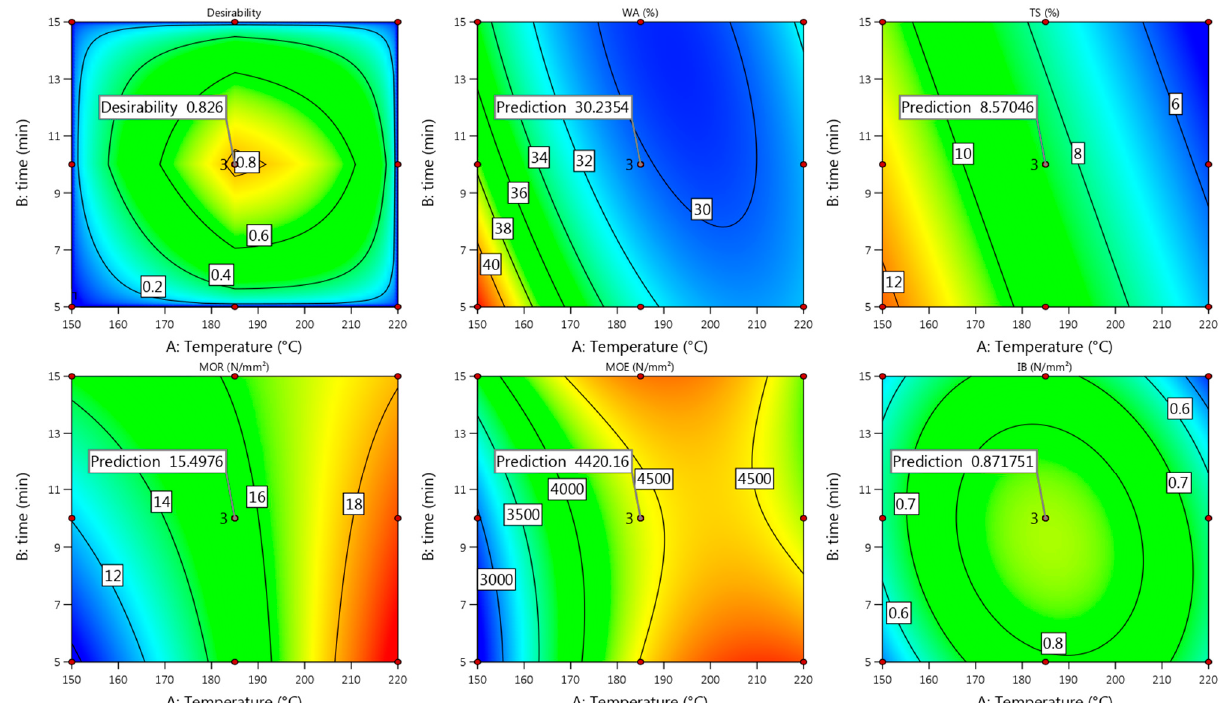
Figure 10. Contour plots with predicted values of Uso-1000 binder-less board properties at T = 185 °C and t = 10 min.